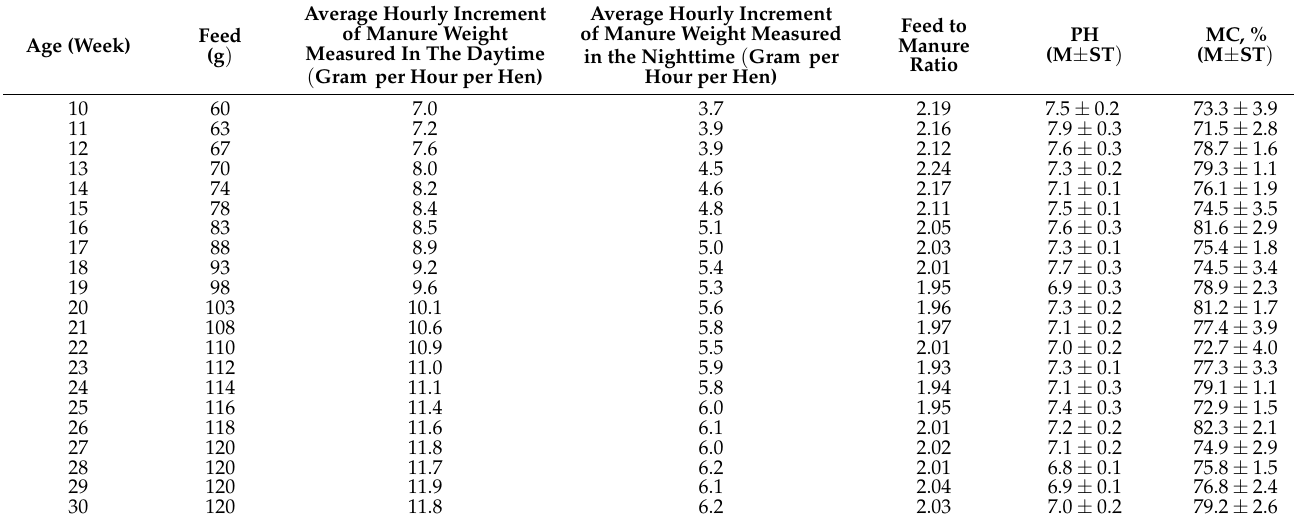
Figure 5. Manure weight measured (per hour per hen) at four typical laying hen ages of ( a ) 12 weeks, ( b ) 18 weeks, ( c ) 24 weeks, and ( d ) 30 weeks. Average value is provided with the standard deviation (error bar). Each test starts at 5 am (lights on) and lasts for 48 h with a measurement interval of one hour. Data between red-dash lines are measured in the daytime (lights on), and data between green-dash lines are recorded in the nighttime (lights off). Table 3. Manure data measured and recorded each week.